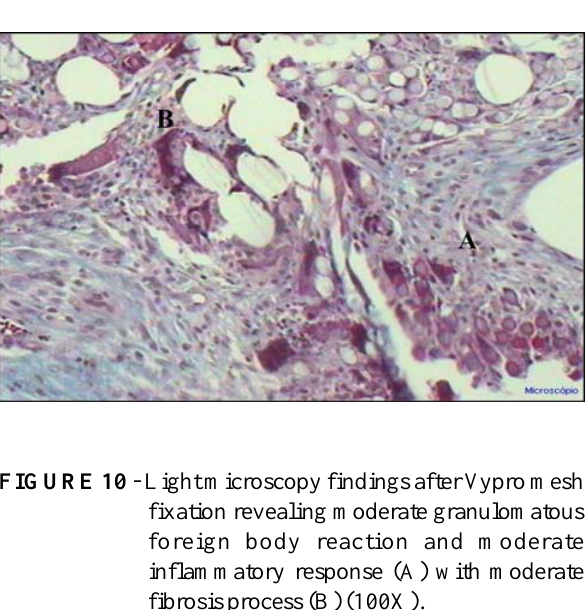
FIGURE 8 - Microscopical findings after Vypro mesh fixation.